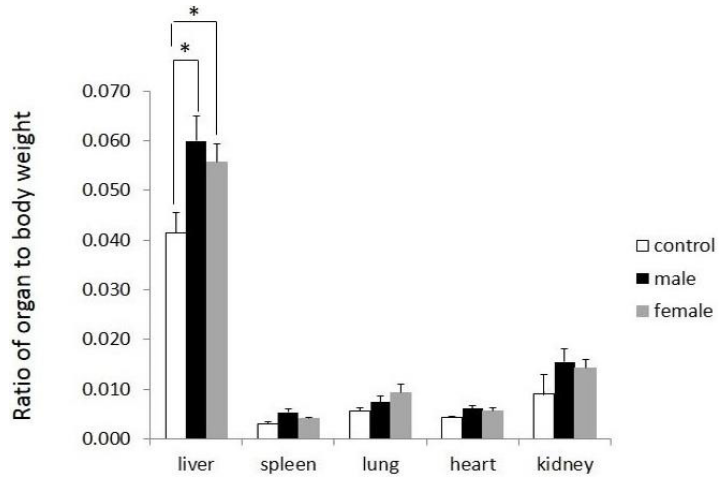
Figure 6. The organ-to-body weight ratios of the internal organs.